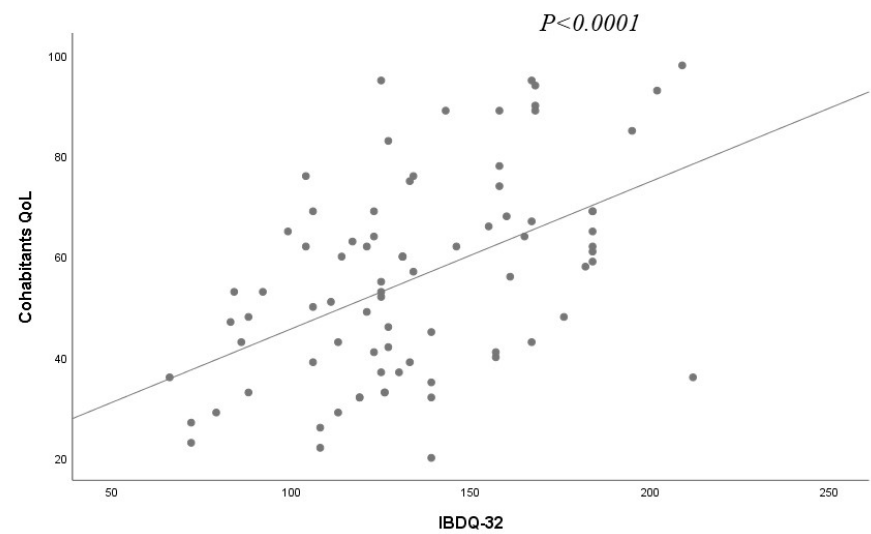
Figure 1. Simple linear regression for cohabitants’ QoL and IBDQ32 scores. Table 2. Univariate analysis of factor potentially related with quality of life in patients.